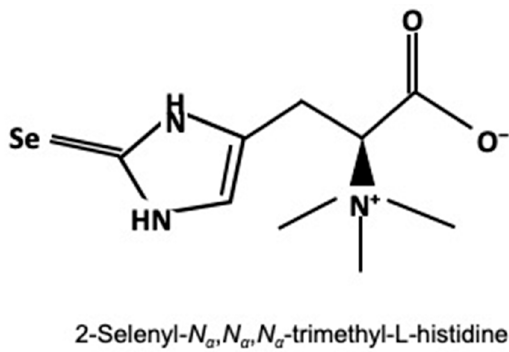
Figure 1. Chemical structure of selenoneine.